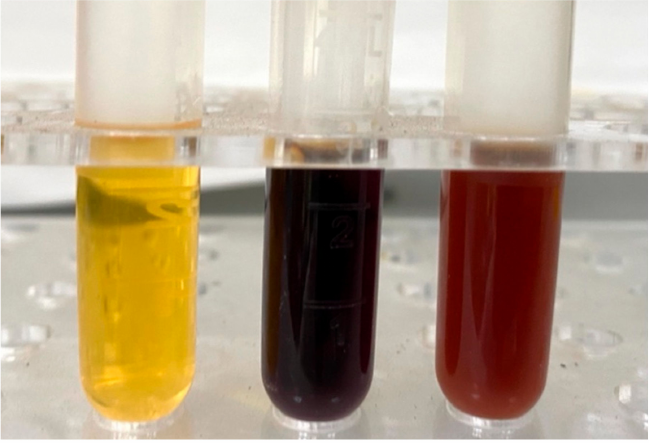
Figure 1. Transparent, purple, and yellow shellac